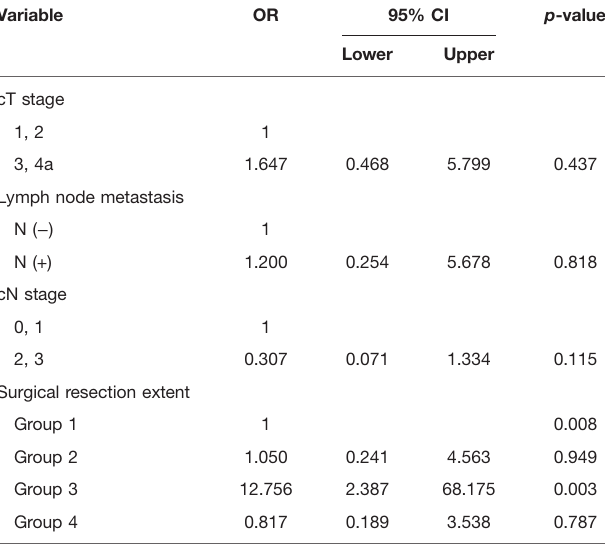
Table 3 | Multivariate analysis of factors related to postoperative